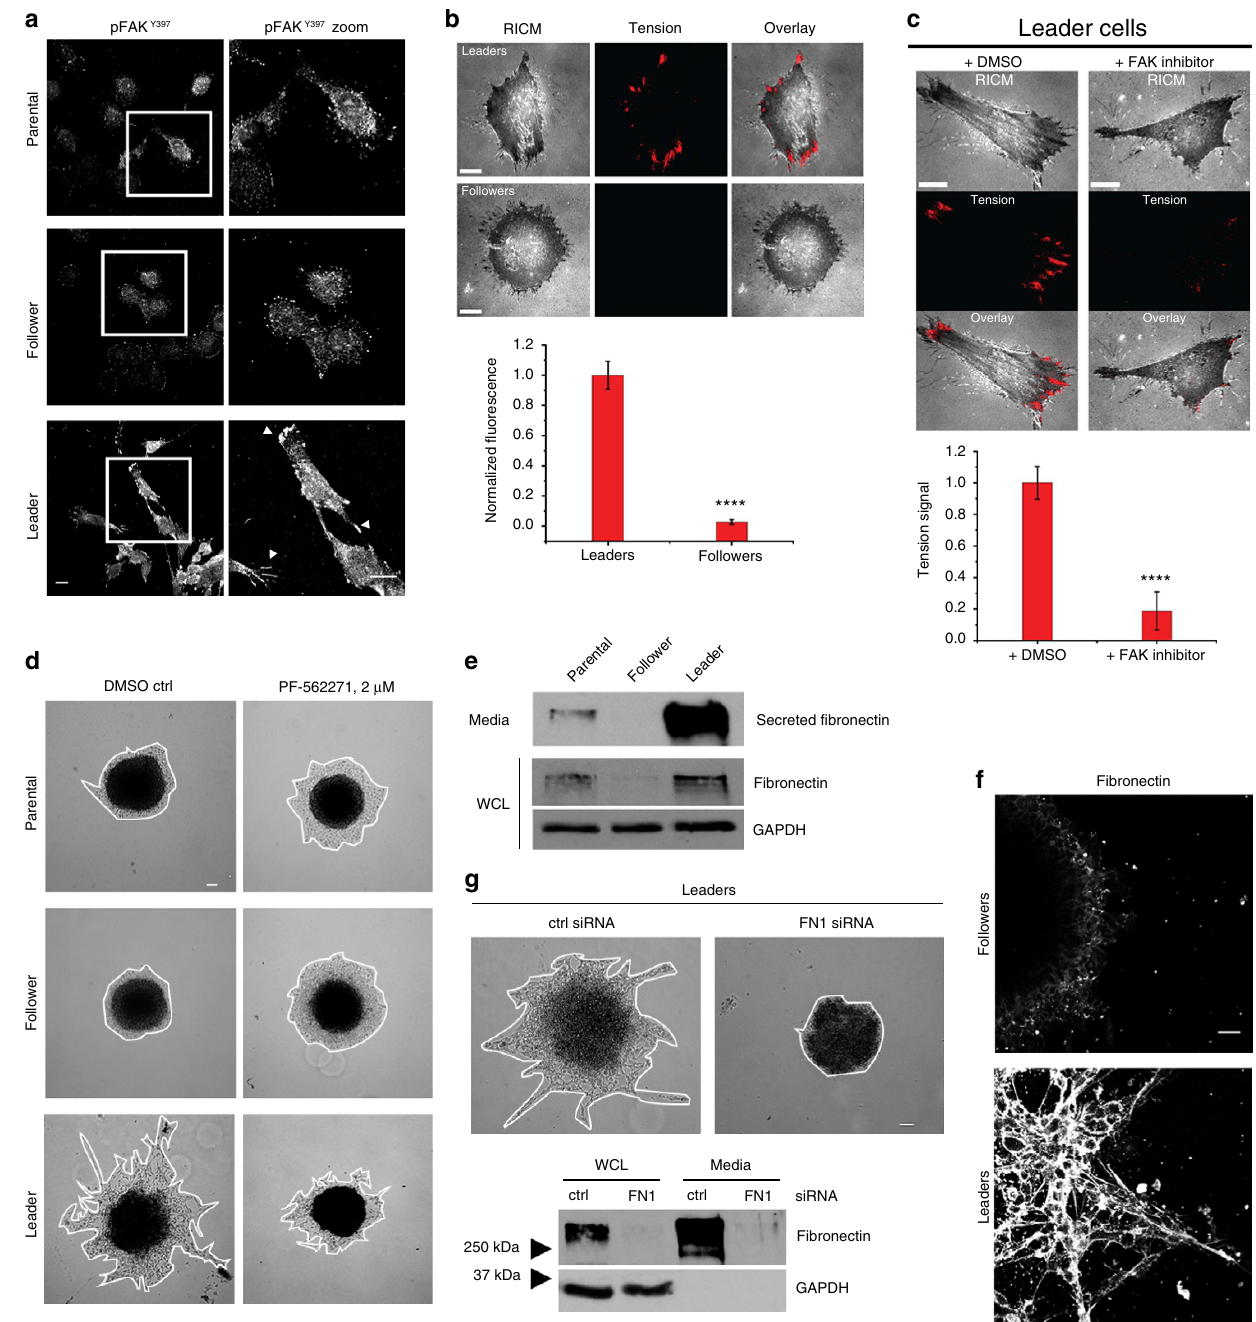
Figure 5 | The fibronectin/FAK pathway drives leader cell invasion. ( a ) Immunofluorescence imaging of pFAK Y397 in H1299 parental, follower and leader cells plated in 2D. Arrowheads denote large adhesion sites in leader cells. Scale bar, 20 m m. ( b ) Representative reflection interference contrast microscopy (RICM) and integrin tension images of leader and follower cells 32 . An overlay of the RICM and integrin tension channels demonstrates that regions at the cell edge associated with FAs generate sufficient tension to unfold the titin-based probe for the leader cells. Plot below shows the average integrin tension signal for leaders and followers. Error bars represent the s.e.m. from 10 cells for each group collected from three chambers, **** P o 0.0001 using a Student’s t -test. Scale bars, 10 m m. ( c ) Representative RICM and integrin tension images for leader cells incubated in the presence of either 0.1% DMSO control and PF-562271 FAK inhibitor. Error bars represent the s.e.m. from 10 cells for each group collected from three chambers, **** P o 0.0001 using a Student’s t -test. Scale bars, 10 m m. ( d ) Spheroid invasion assay with H1299 parental, follower or leader cells in the presence of 2 m M PF-562271 FAK inhibitor or DMSO control. Scale bar, 100 m m. ( e ) Western blot of fibronectin protein in the media or WCL of H1299 parental, follower and leader cells. GAPDH was a loading control. ( f ) Immunofluorescence of extracellular fibronectin in follower and leader spheroids. Scale bar, 50 m m. ( g ) Fibronectin ( FN1 ) was knocked down in leader cells using targeted siRNA. Scrambled siRNA was used as a negative control. Spheroids from FN1 siRNA-treated leader cells were assayed for invasion compared to control. Western blot below confirms knockdown efficiency. Scale bar, 100 m